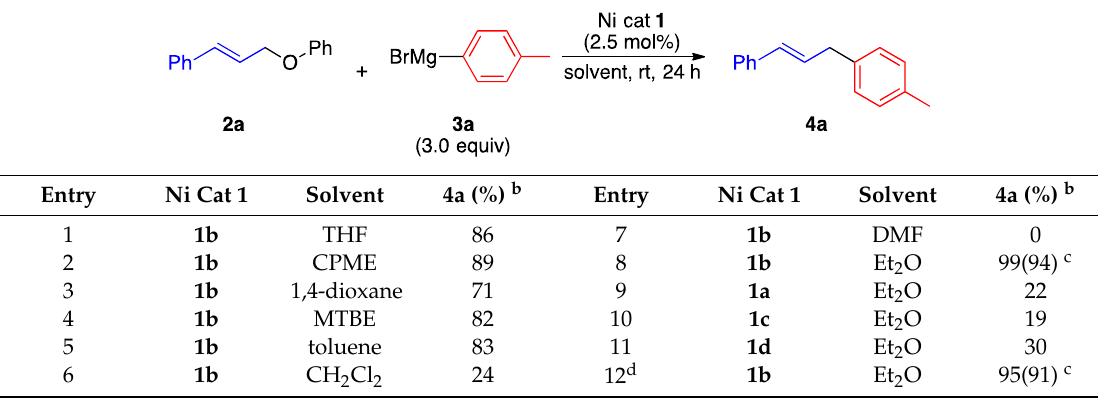
Table 2. Solvent screening using the reaction between 2a and 3a with complex 1 . a